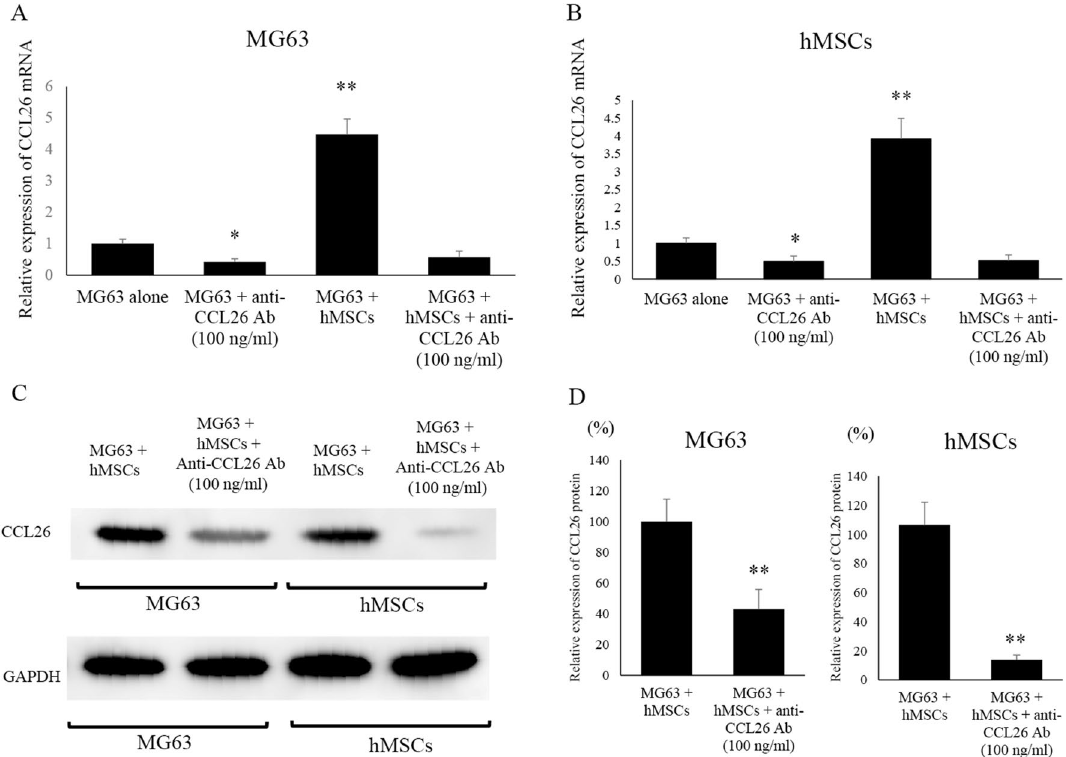
Figure 3. Effects of neutralizing anti-CCL26 Ab on CCL26 expression in mono-cultured and co-cultured MG63 and hMSCs. ( A ) Changes inCCL26 expression in MG63 were assessed by qRT-PCR. The addition of antiCCL26 Ab to MG63 decreased the expression ofCCL26 mRNA. ( B ) Changes inCCL26 expression in hMSCs were assessed by qRT-PCR. The addition of anti-CCL26 Ab to hMSCs decreased the expression ofCCL26 mRNA. ( C ) Changes inCCL26 protein expression in hMSCs and MG63 were assessed by western blot analysis. The addition of anti-CCL26 Ab to MG63 and hMSCs decreased the expression ofCCL26 protein in these cells. ( D ) The quantification of western blot analysis. Data represents represent the mean ± SD of three independent experiments. p < 0.05 was considered to indicate significance: (*) p < 0.05, (**) p <